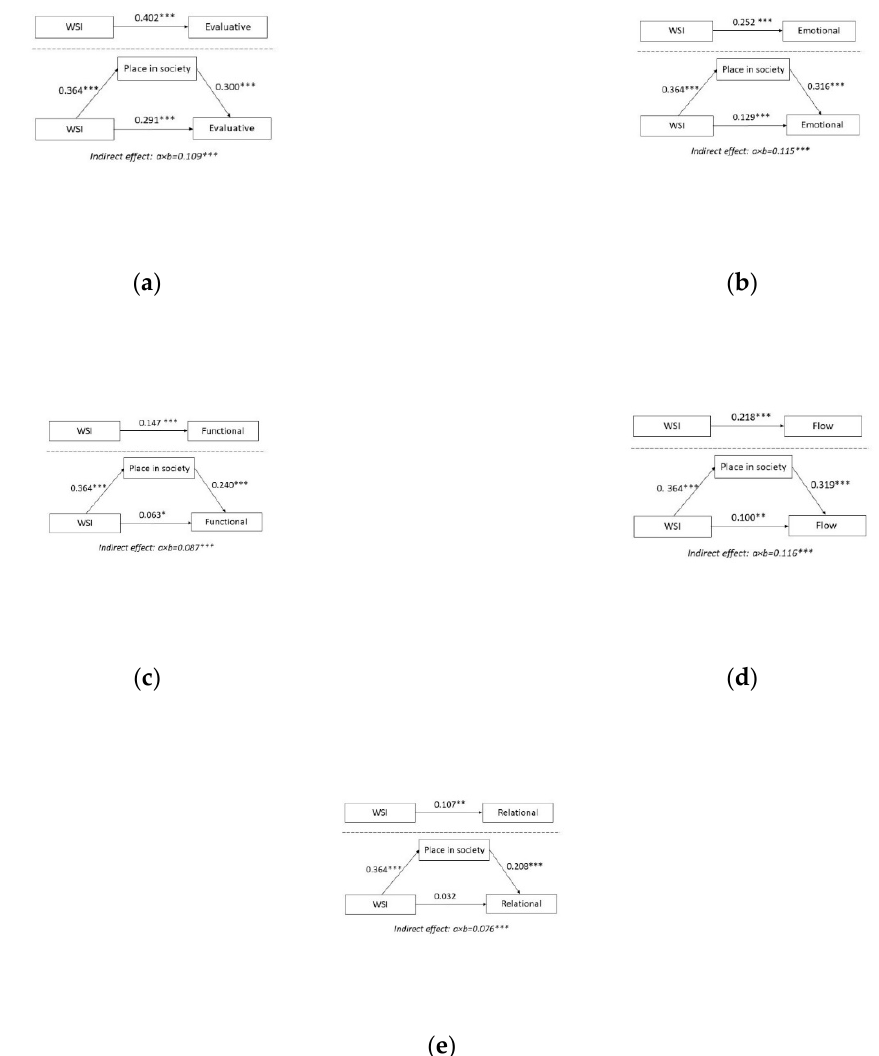
17 of 20 Figure 2. Coping with income intervening variable: ( a ) Evaluative dimension. ( b ) Emotional dimen- sion. ( c ) Functional dimension. ( d ) Flow dimension. ( e ) Relational dimension. Significance level de-